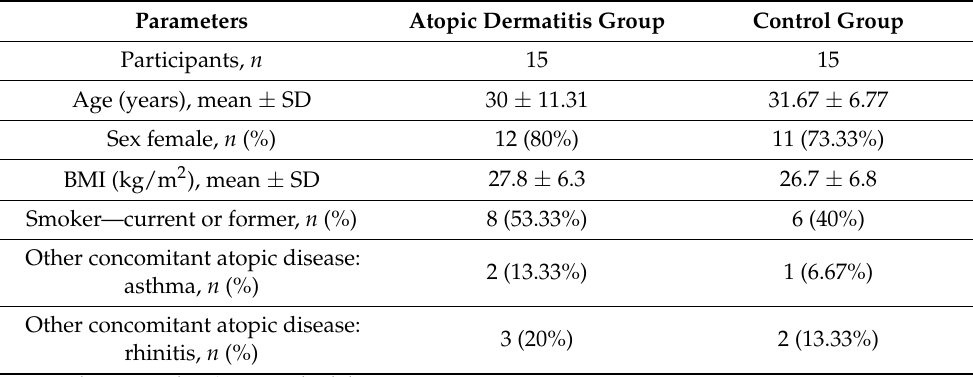
Table 1. Demographic data of the examined groups. Parameters Atopic Dermatitis Group Control